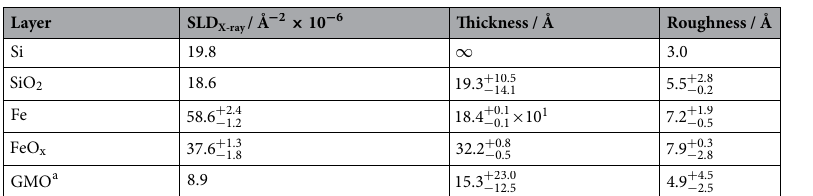
Table 3. XRR fitted parameter values for the iron-coated silicon substrate in air and with a 20 mM GMO solution entrained against the substrate at 3.0 × 10 3 s − 1 . The central parameter values are the median values obtained from the bootstrap routine, with the 95% confidence intervals reported in the sub- and superscripts. Those values without uncertainties were held constant. a Layer only included in the 20 mM GMO solution